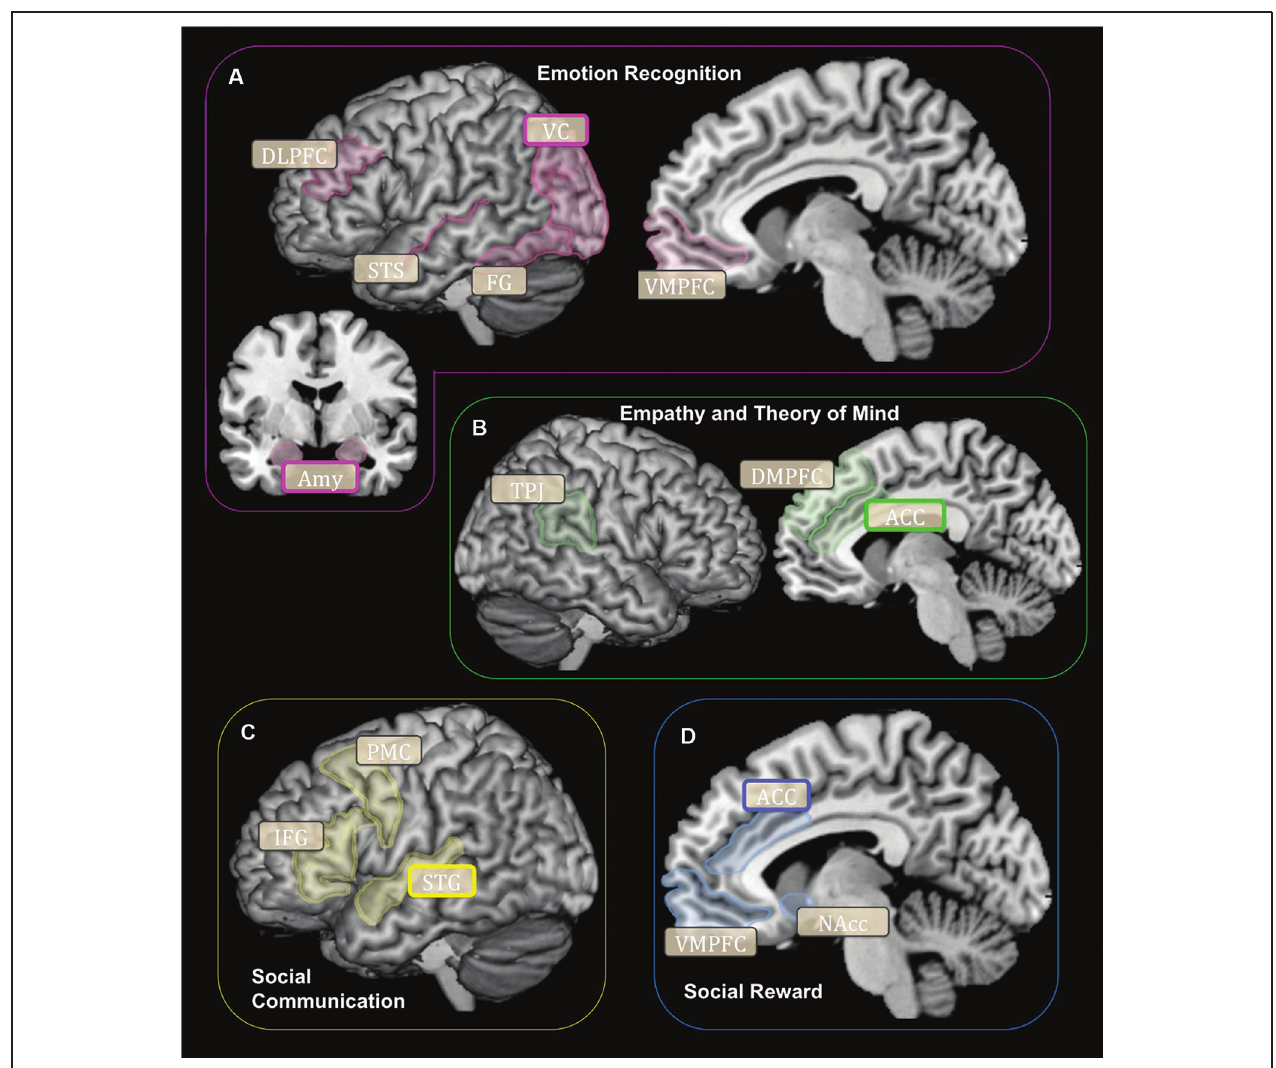
regions shown to be structurally or functionally different according to the OXTR gene (SNPs or methylation) in humans. DLPFC, Dorsolateral Prefrontal Cortex; VC, Visual Cortex; STS, Superior Temporal Sulcus; FG, Fusiform Gyrus; VMPFC, Ventromedial Prefrontal Cortex; Amy, Amygdala; TPJ, Temporoparietal Junction; ACC, Anterior Cingulate Cortex; PMC, Premotor Cortex; IFG, Inferior Frontal Gyrus; STG, Superior Temporal Gyrus; NAcc, Nucleus